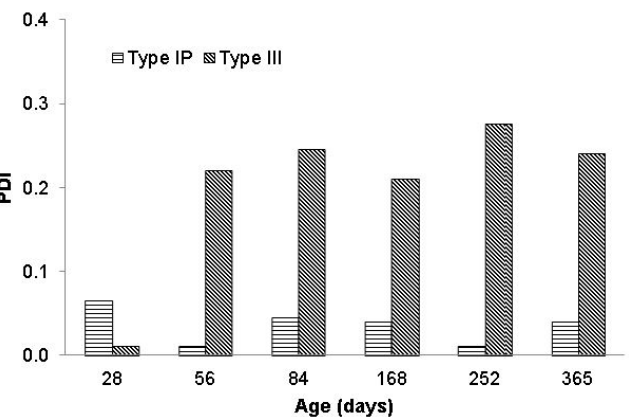
Figure 18. Plastic Deformation Index (PDI) of concretes over time.